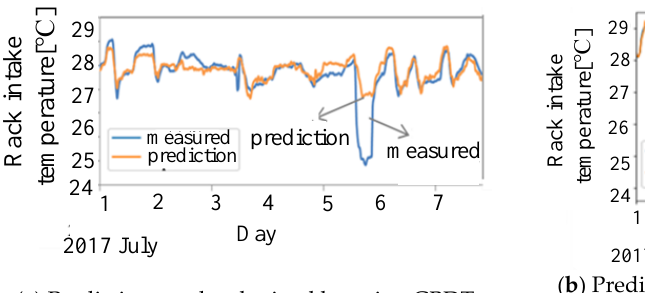
Table 8. Relationship between learning period and evaluation period.